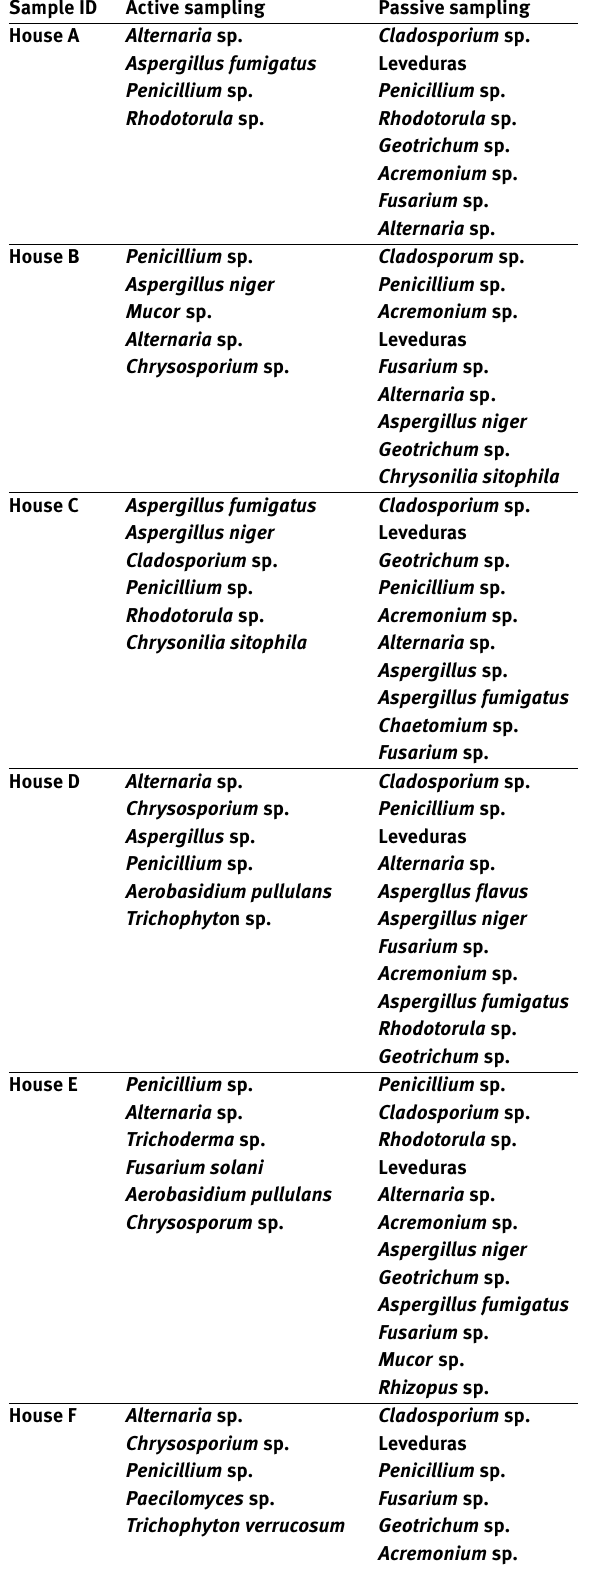
Table 3. Identification of fungi found at each house using dust sam- ples from the vacuum cleaner bag (active sampling) and from the deposited dust on petri dishes (passive